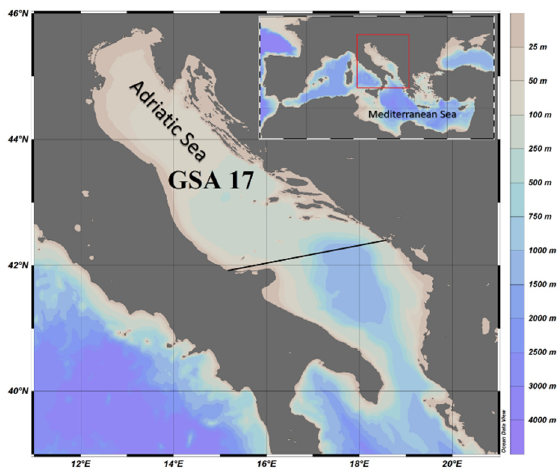
Figure 1. Map of the sampling area in the northern and central Adriatic Sea (FAO-GFCM geographical sub-area GSA 17), and central Mediterranean Sea.